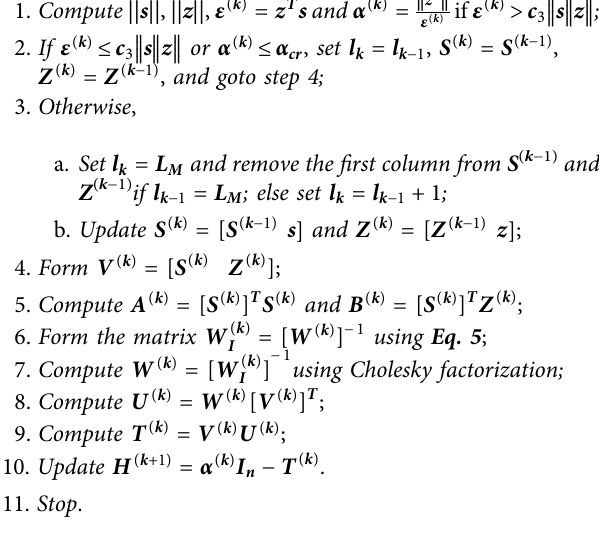
Algorithm-1: Updating the Hessian directly using the L-BFGS compact representation